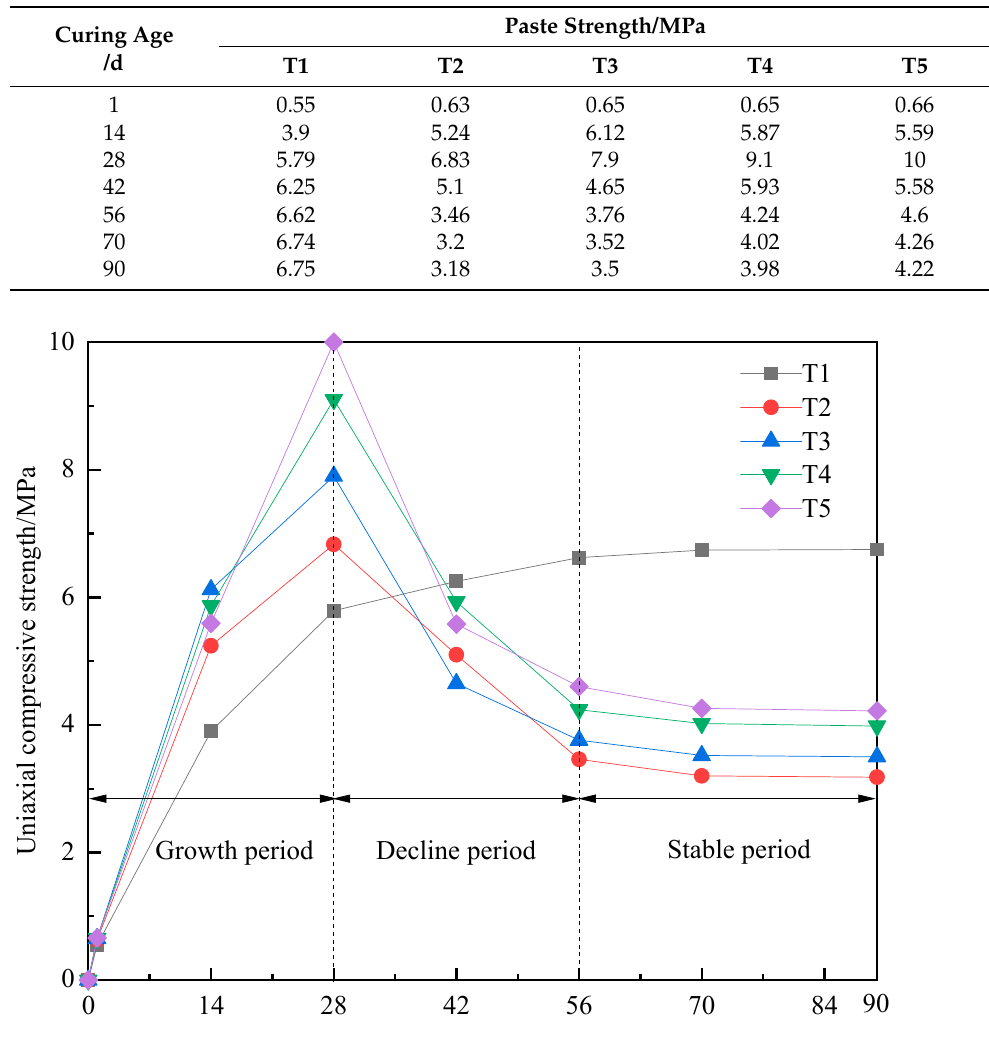
Table 3. Compressive strength of the filling concrete at different curing ages.